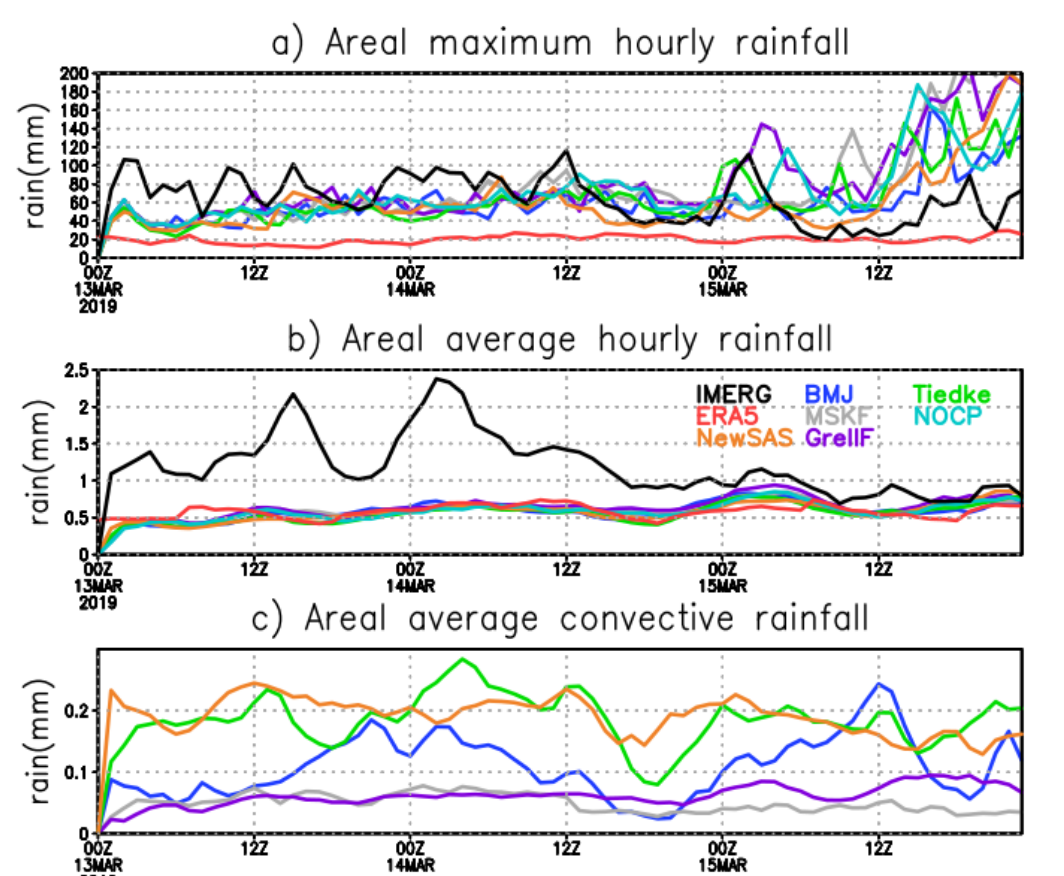
Figure 7. ( a ) The maximum rainfall over the model domain, ( b ) the area average hourly rainfall and ( c ) the area average convective rainfall. The results are shown for IMERG (black) and ERA5 (red) in ( a , b ) as well as from WRF simulations using the NewSAS scheme (orange), the BMJ scheme (blue), the MSKF scheme (grey), the Grell–Freitas scheme (purple), the new Tiedtke scheme (green) and the simulation without a cumulus scheme